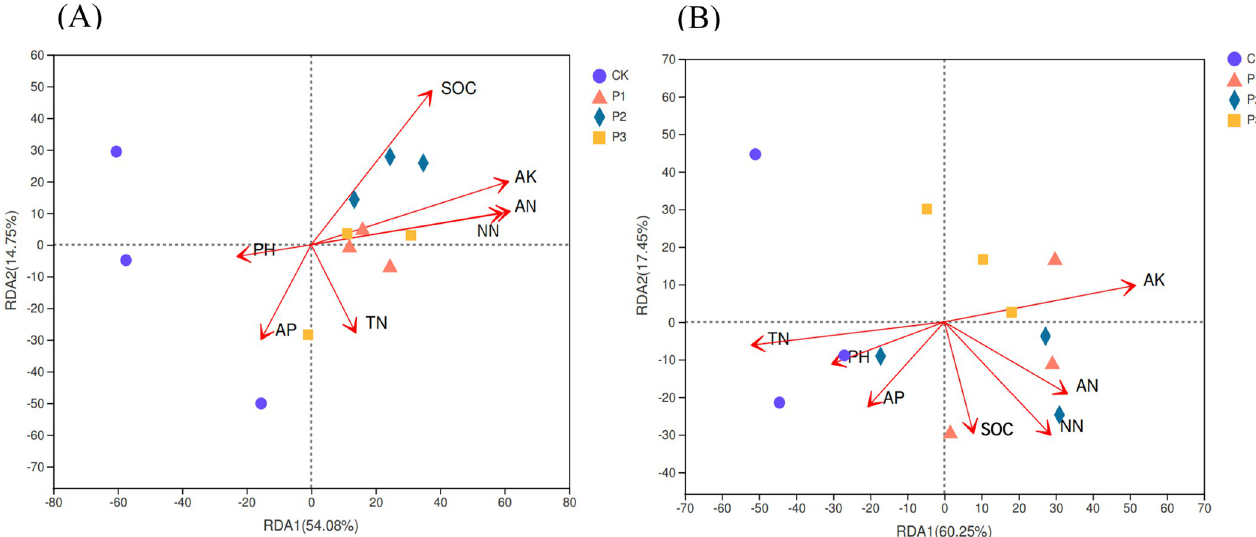
Fig 5. Redundancy analysis (RDA) of bacterial community composition and soil chemical properties. A is 0–30 soil layer, B is 30–60 cm soil layer. SOC stands for soil organic carbon; TN stands for soil total nitrogen; AP stands for available phosphorus; AK stands for available potassium; NN stands for NO 3- -N; AN stands for NH 4+